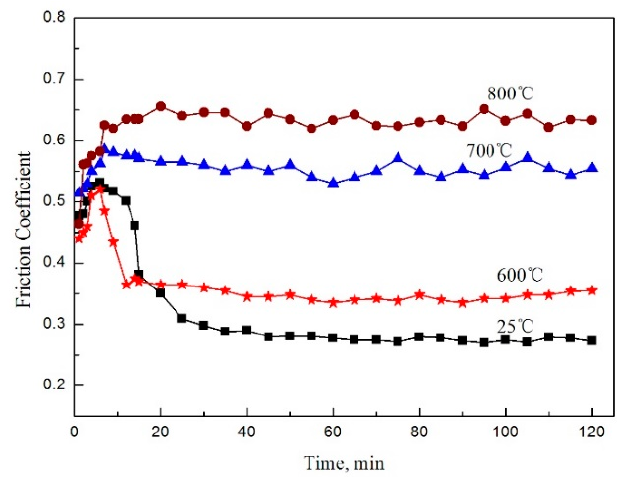
Figure 3. Friction coefficient vs. time curves of friction pairs.